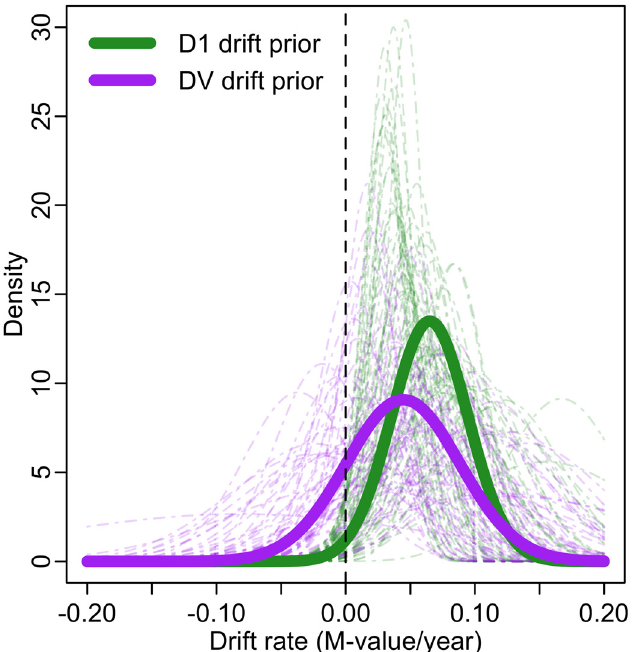
Fig 5. Validation of methylomic drift. Normal distributions derived from regressions using M-values from serial data set D1 across 67 CpGs individually (light dashed green curves) and combined (solid green line). Similar normal distributions derived from regressions using M-values from serial data set DV across these 67 CpGs individually (light dashed purple curves) and combined (solid purple line) are also plotted. Both prior choices from D1 and DV (solid lines) are shifted to the right of zero (vertical dashed black line) depicting validated positive drift in BE tissue for the BE clock CpG